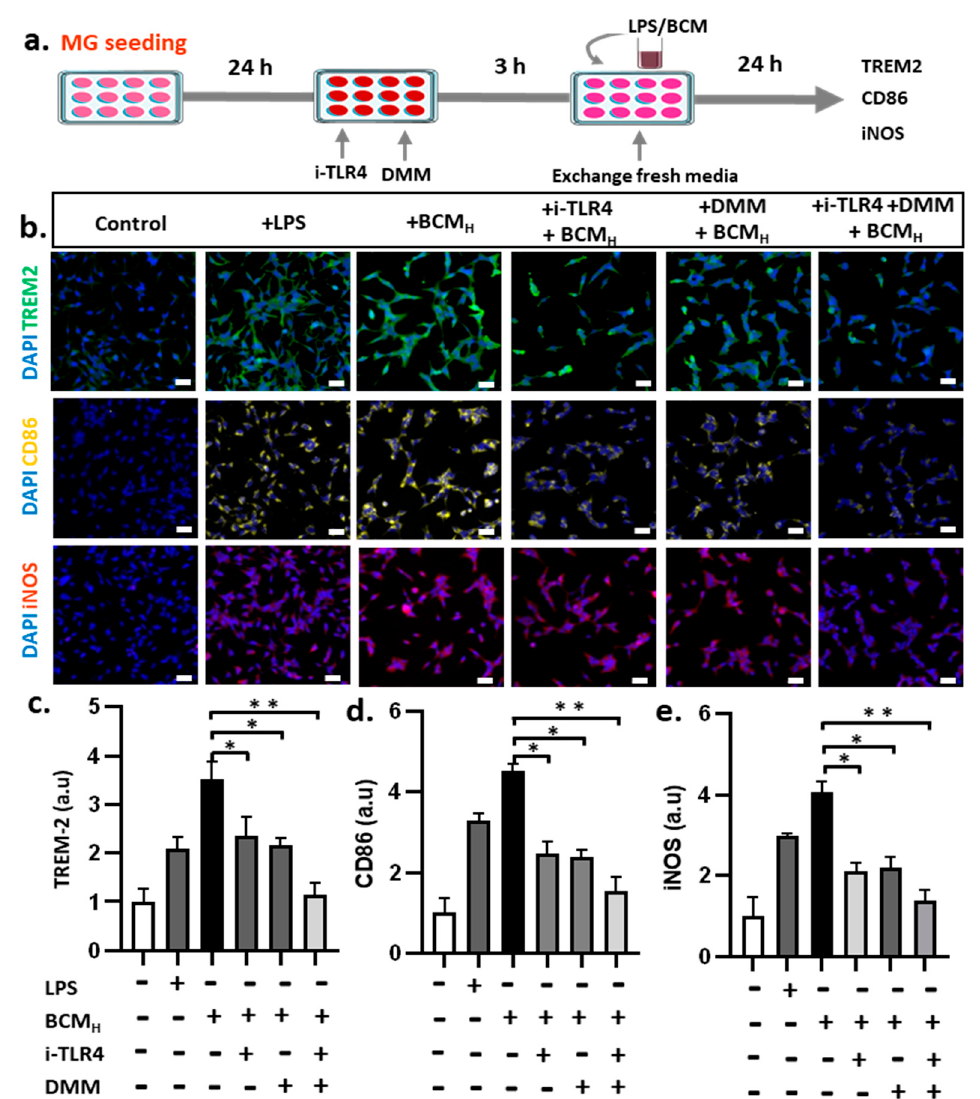
Figure 6. Inhibition of succinate dehydrogenase and LPS reducing microglial inflammatory responses. ( a ) Schematic showing experimental timeline for inhibition assay. ( b ) Immunostaining images against TREM-2, CD86 and iNOS markers of microglia cells. ( c – e ) Quantification of TREM2, CD86 and iNOS fluorescent intensity expressed by stained microglia cells. All experiments were repeated three times independently and statistically analyzed by One-way ANOVA followed by Tukey HSD test (* p < 0.05, ** p < 0.01). All data were presented as mean ± standard deviation (SD).